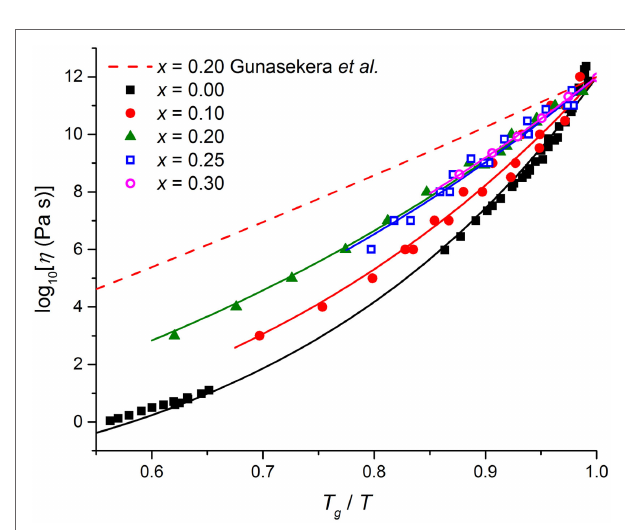
FIGURE 11 | The dependence of log 10 [ (cid:17) (Pas)] on the ratio of absolute temperatures T g / T . The solid curves show fits of the MYEGA model to the measured viscosity data shown by the symbols for Se (Cukierman and Uhlmann, 1973; Koštál and Málek, 2010; Gueguen et al., 2011), Ge 0.10 Se 0.90 (Nemilov, 1964; Senapati and Varshneya, 1996; Gueguen et al., 2011), Ge 0.20 Se 0.80 (Nemilov, 1964; Gueguen et al., 2011), Ge 0.25 Se 0.75 (Nemilov, 1964; Senapati and Varshneya, 1996; Gueguen et al., 2011), or Ge 0.30 Se 0.70 (Gueguen et al., 2011), where the logarithm of the high-temperature viscosity was treated as a fixed parameter set at log 10 [ (cid:17) 1 (Pas)] = − 2.93 (Zheng et al., 2011). The broken (red) curve shows the prediction at x = 0.20 of the MYEGA model if the fragility index m visc is equated to m DSC = 17.7 as found in the TMDSC measurements of Gunasekera et al. (2013) (see Figure 12